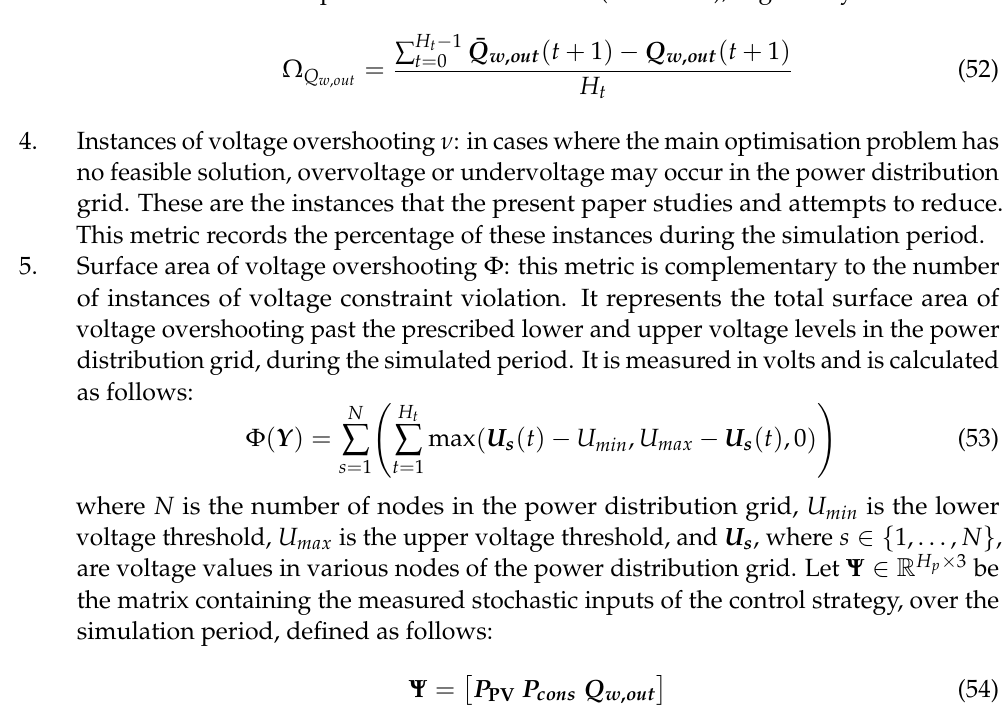
Ω Q w , out , which is the mean deviation of water demand values ( Q w , out ) from the ones forecasted at a one-step-ahead forecast horizon (in m 3 h − 1 ), is given by: